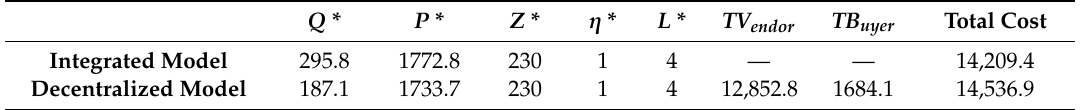
Table 3. The optimal results for Example